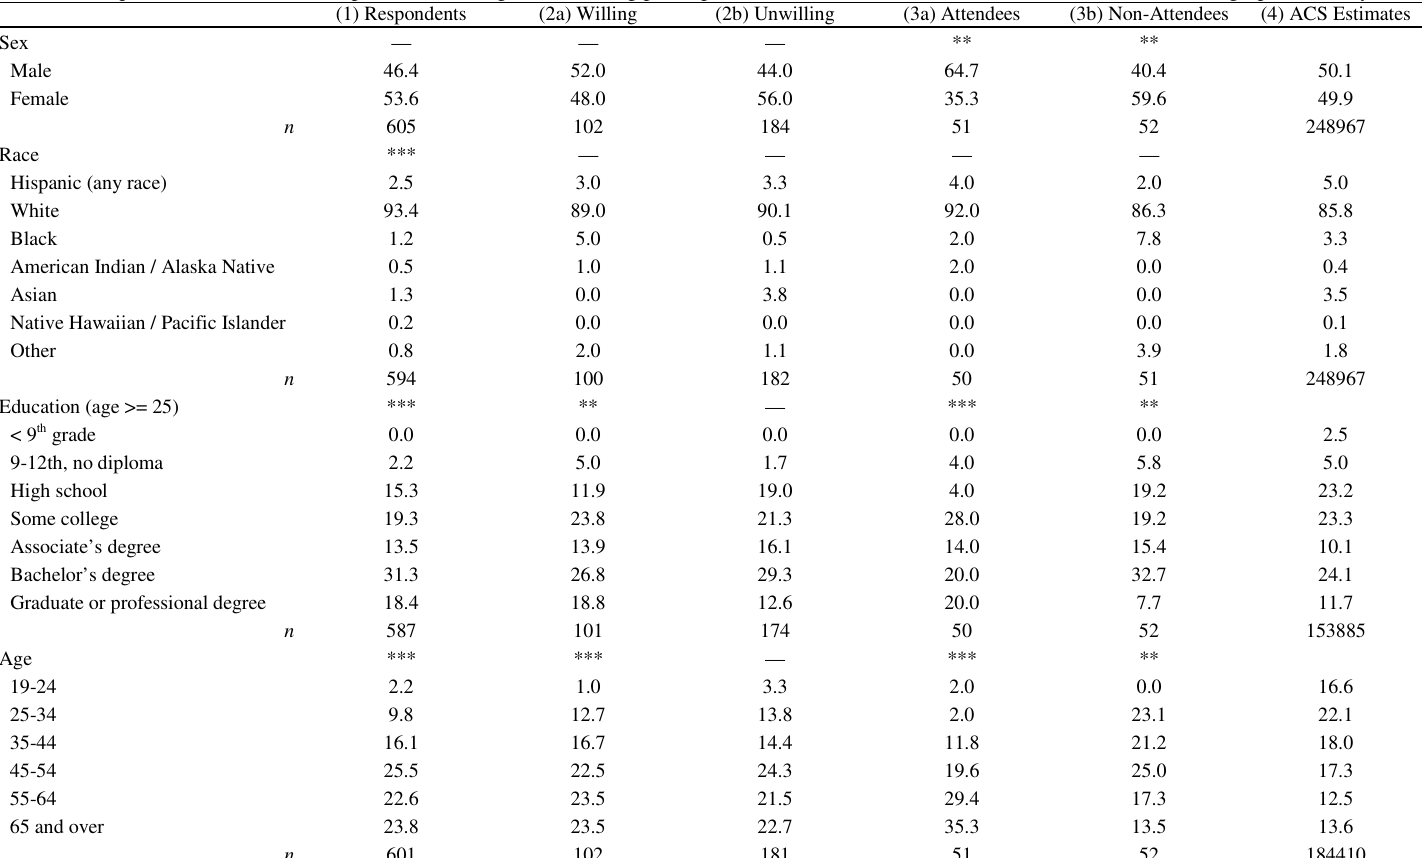
Table 2. Comparison of recruitment respondents, willing and unwilling participants, event attendees and nonattendees, and Census demographics (Study